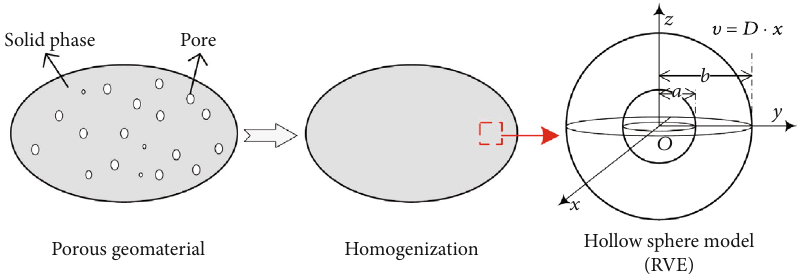
Figure 1: Porous geomaterials and hollow sphere model with uniform strain rate boundary